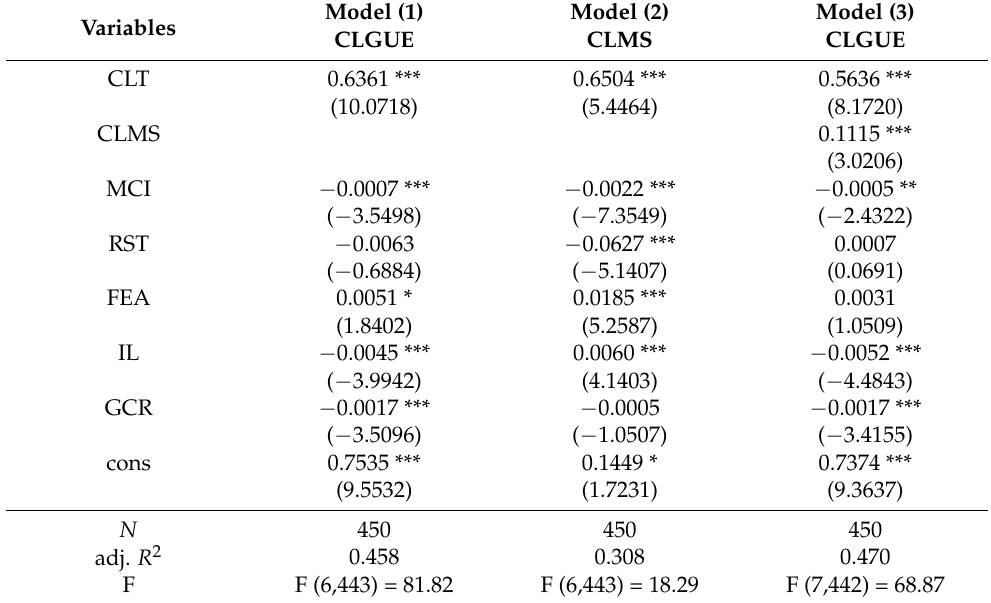
Table 4. Hierarchical Regression Results.